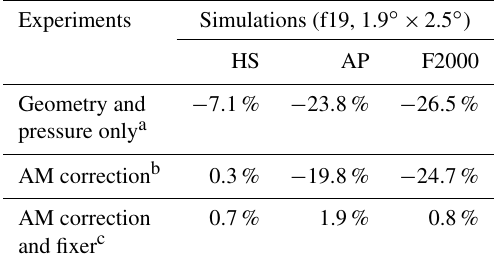
Table 1. Simulation set-ups and the effect of AM modifications. The percentage figures represent the numerical source (negative for sink) of global total atmospheric AM relative to the global to- tal physical eastward torque acting on the atmosphere (terms T x and C λ in Eq. (A1), when only the positive parts of the integrands are summed). The column “Experiments” indicates which modifi- cations to CAM–FV are used (the relevant sections of this paper are indicated in the footnotes). The three columns under “Simu- lations” are for results obtained with model integrations in Held– Suarez mode (Held and Suarez, 1994), in aquaplanet mode (Neale and Hoskins, 2000), and in F2000 mode, i.e. an AMIP-type (Gates, 1992) simulation with annually repeating present-day climatologi- cal